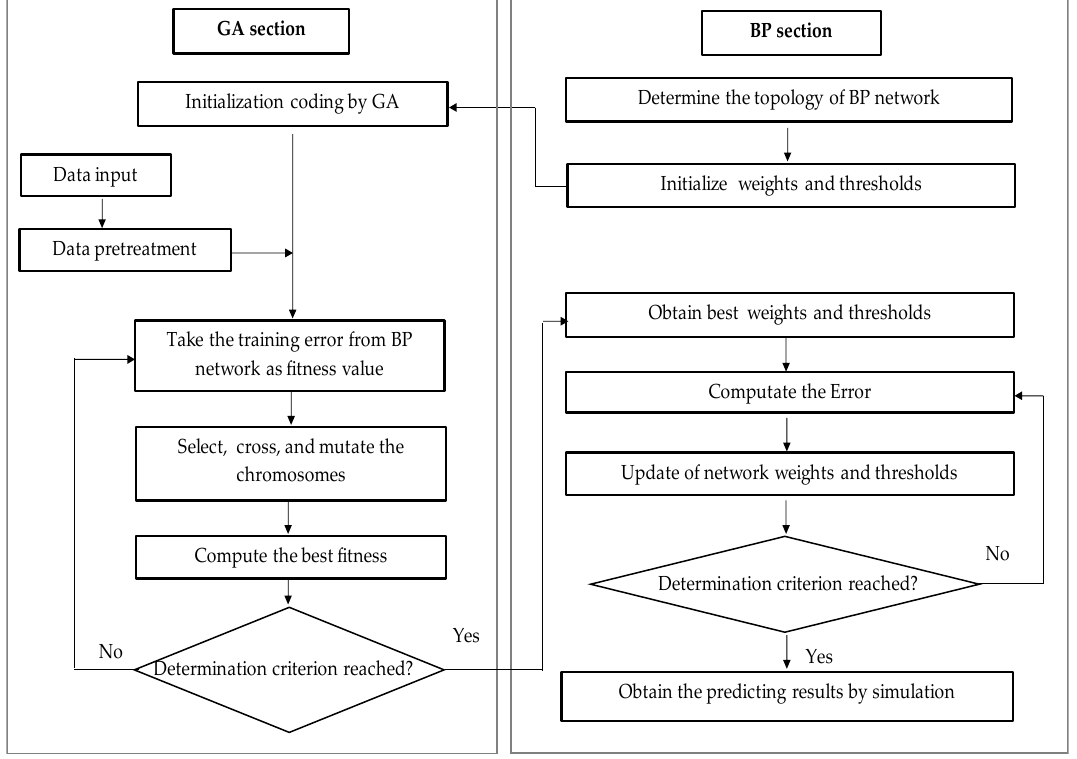
Figure 14. Flow chart of a GA-BP neural network.